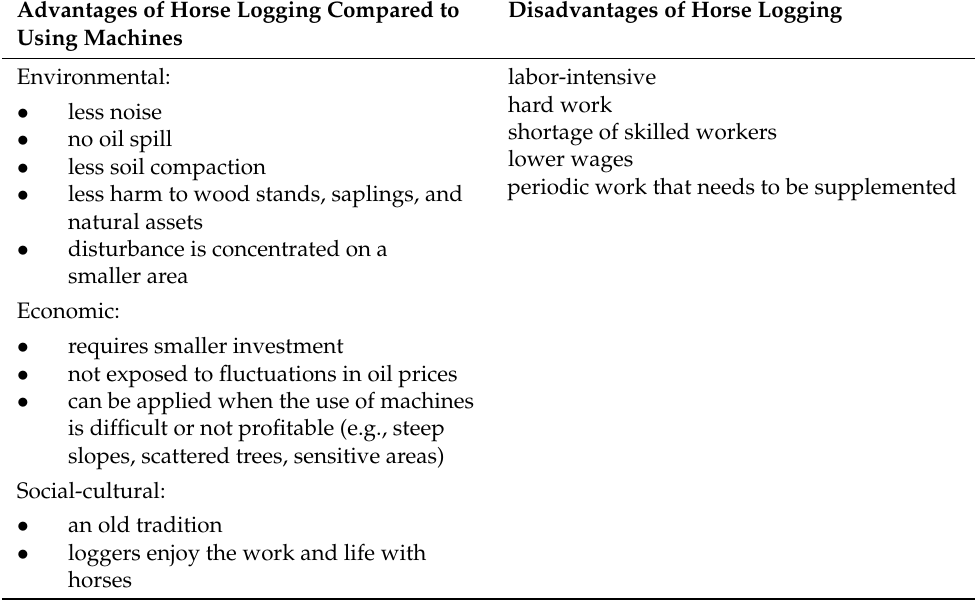
Table 5. Advantages and disadvantages of horse